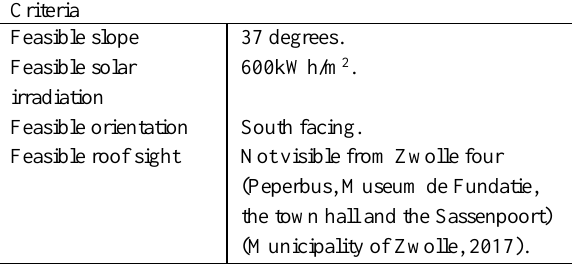
Table 2. Criteria applied for suitability analysis.